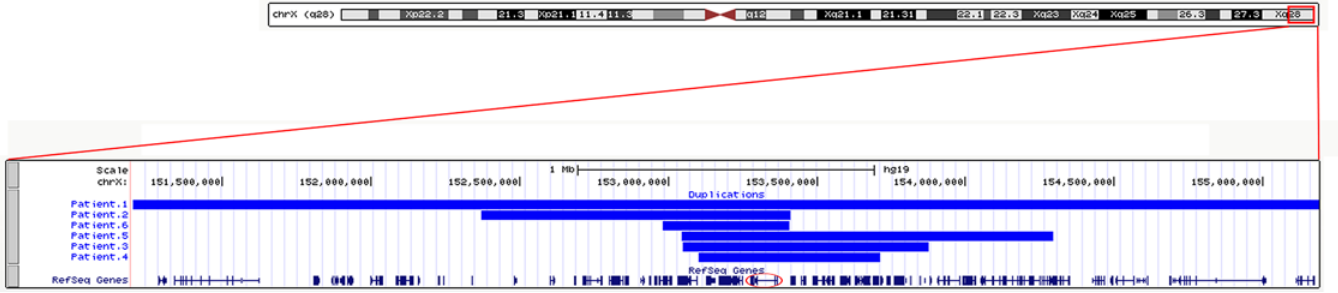
Fig 1. Graphical view of the MECP2 duplications/triplication. Graphical view of the MECP2 duplications/triplication was created with custom tracks in the UCSC genome browser (GRCh37/hg19), (Patient 1 was identified with a triplication). The involved regions are shown in blue and MECP2 is marked by a red